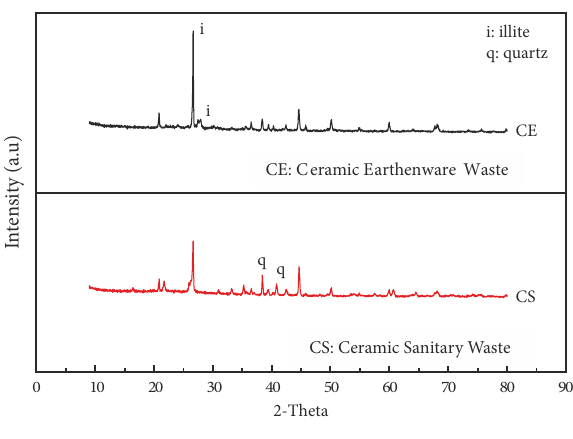
Figure 1. X-ray diffraction of materials